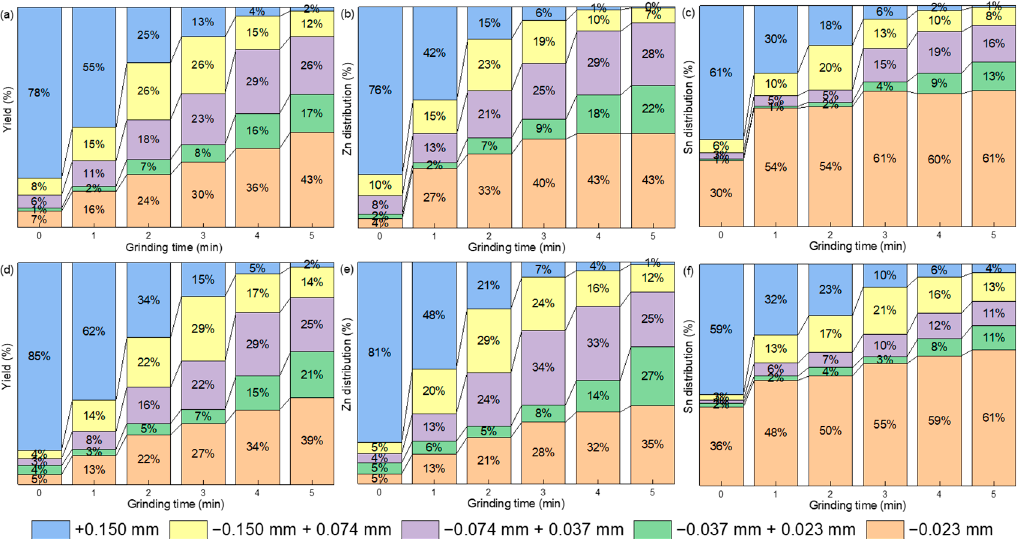
Figure 6. ( a ) Yield in each particle size of raw ore grinding products; ( b ) Zn distribution in each particle size of raw ore grinding products; ( c ) Sn distribution in each particle size of raw ore grinding products; ( d ) Yield in each particle size of pebble grinding products; ( e ) Zn distribution in each particle size of pebble grinding products; ( f ) Sn distribution in each particle size of pebble grinding products.